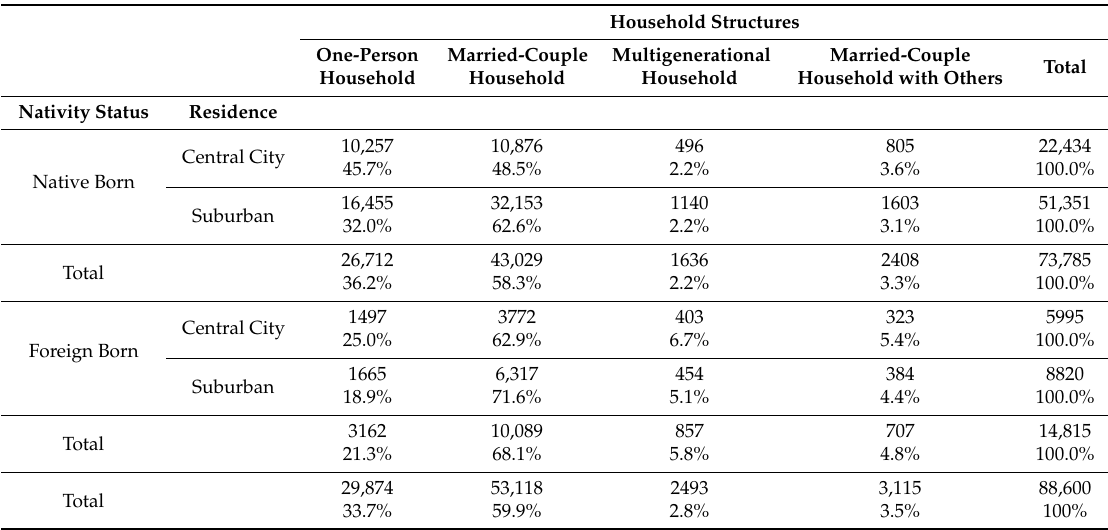
Table 1. Distribution of Household Structure across Residence and Nativity Status. Household